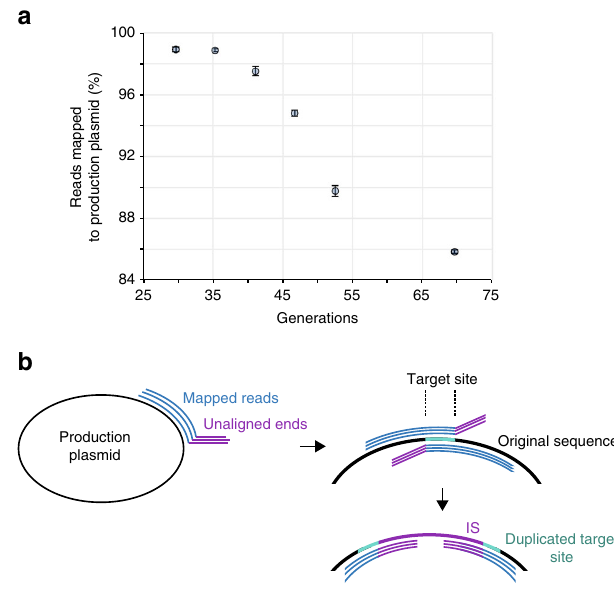
Fig. 3 Inferring invasion of deep-sequenced fermentation cell populations by foreign genetic material. a Percentage of total reads mapped to the production plasmid sequence declined over the course of the fermentation (cell generations; error bars depict s.e.m., n = 3, except generation 70: n = 5). b Analysis of mapped reads indicated insertion sequence (IS) transposition owing to the presence of crossed-over broken read mappings representing IS insertion and the duplication of target sites, also evident from elevated target site sequencing coverage (Supplementary Fig.